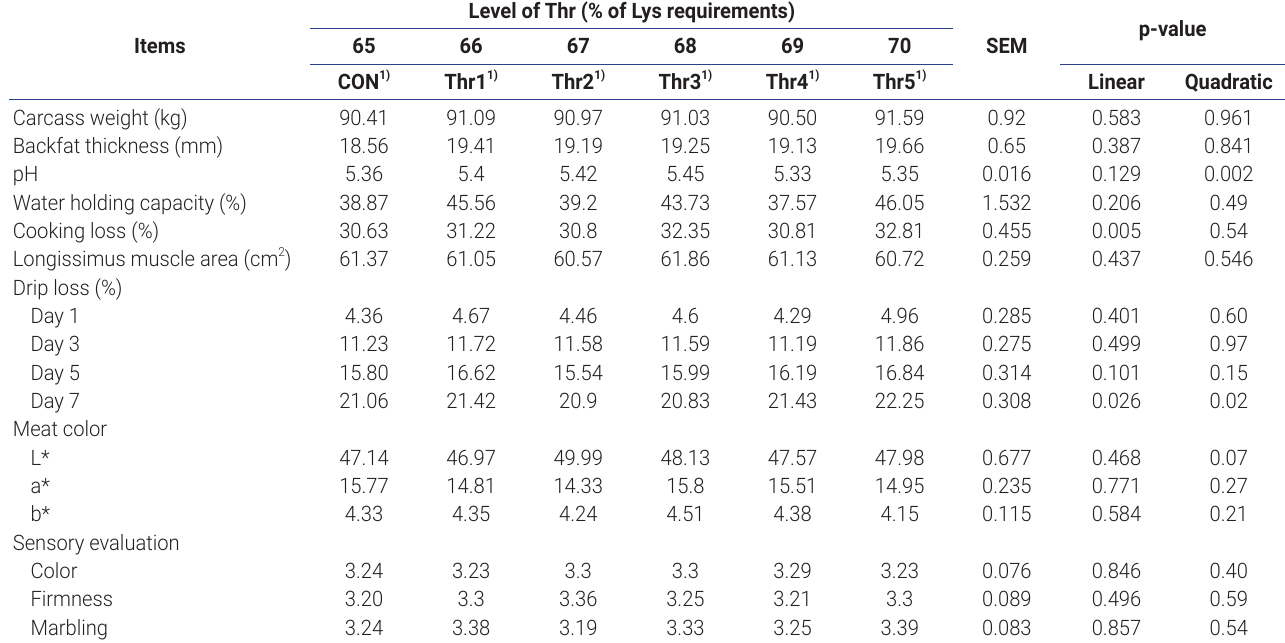
Table 5. Effect of varying dietary Lys:Thr ratios on carcass trait and meat quality in finishing pigs